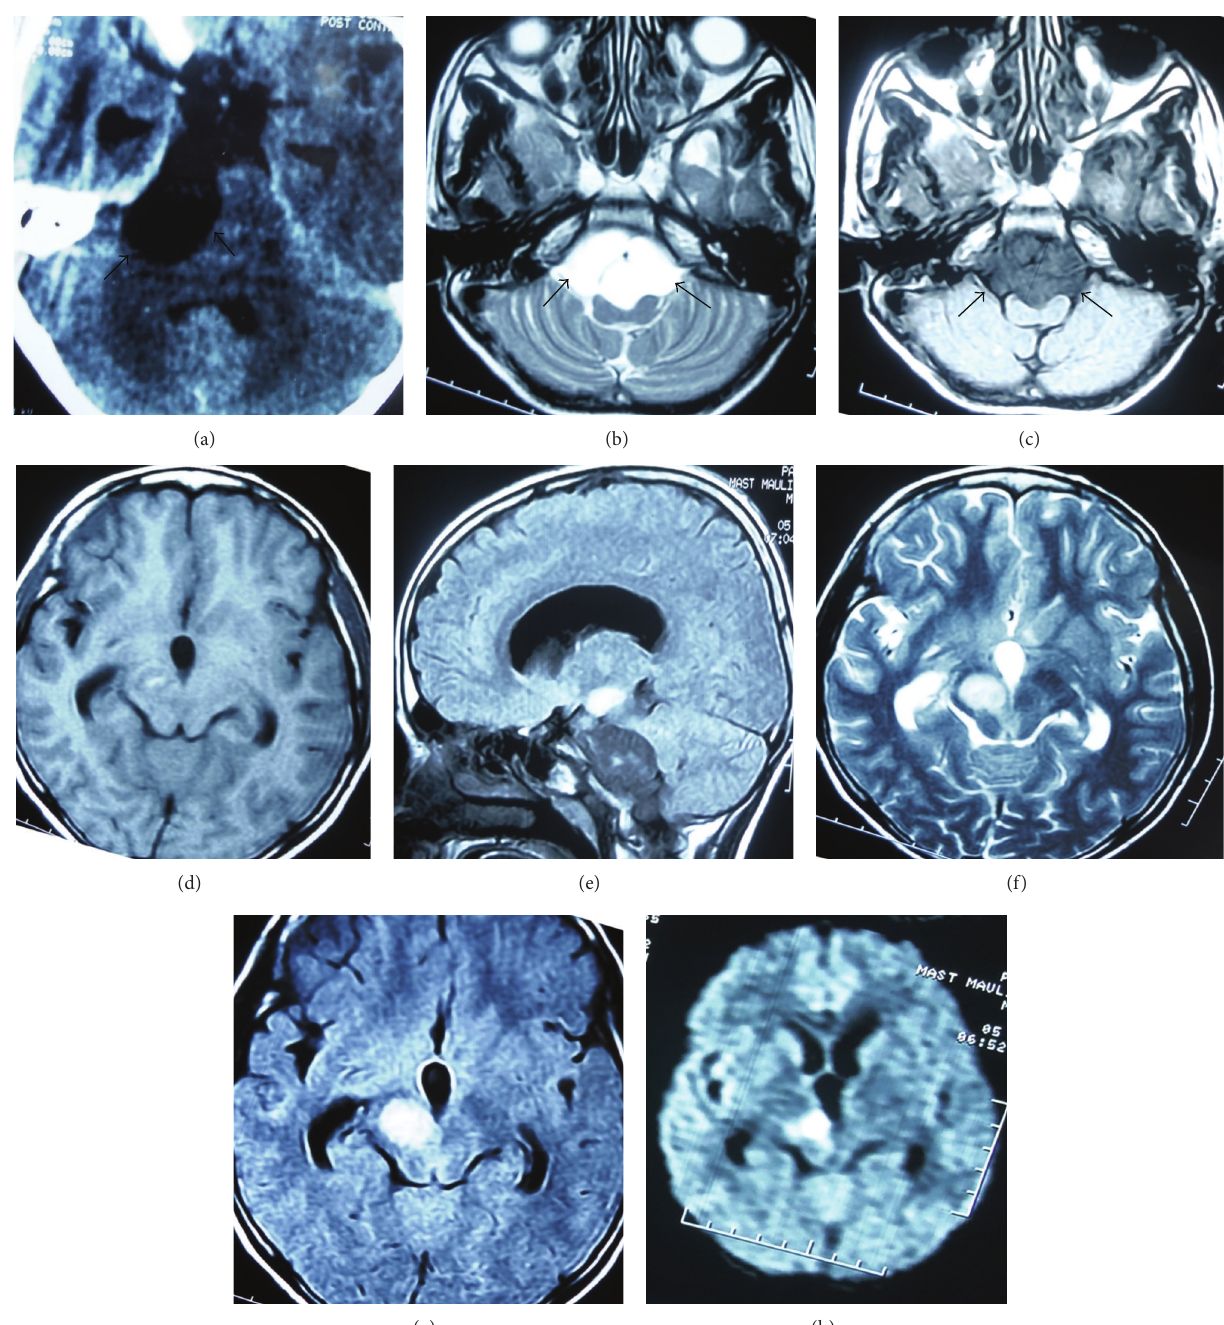
Figure 1: (a) Axial image of plain computed tomography (CT) showing hypodense lesion in right cerebellopontine angle and prepontine cistern with compression of the brainstem. Axial T2 (b) and T1 (c) weighted MR images showing the lesion to be hypointense on T1 and hyperintense on T2 sequence (black arrows outline the tumour). (d) and (e) are T1 weighted axial and sagittal images. (f), (g), and (h) are axial T2, FLAIR, and diffusion weighted images, respectively, revealing another lesion of hyperintensity and restricted diffusion in right half of